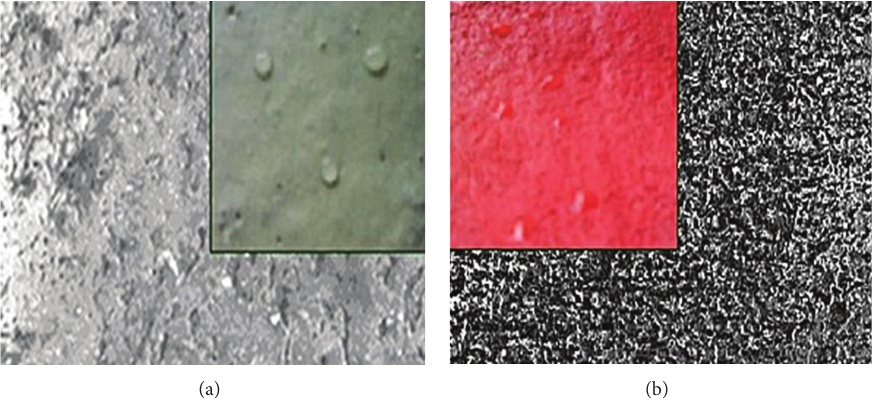
Figure 10: Water droplet test of LC, (a) with TOP of superhydrophobic and (b) without TOP of superhydrophobic property.